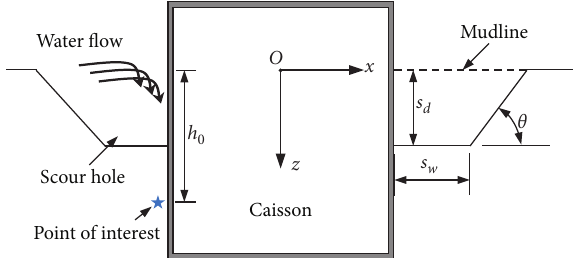
Figure 2: Illustration of the scour hole around the caisson foundation.